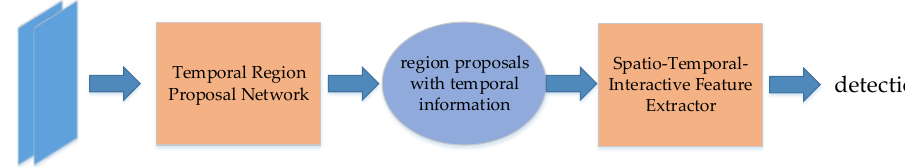
Figure 28. The work flow of High Quality Object Linking. Figure 29. The flow chart of STINet.